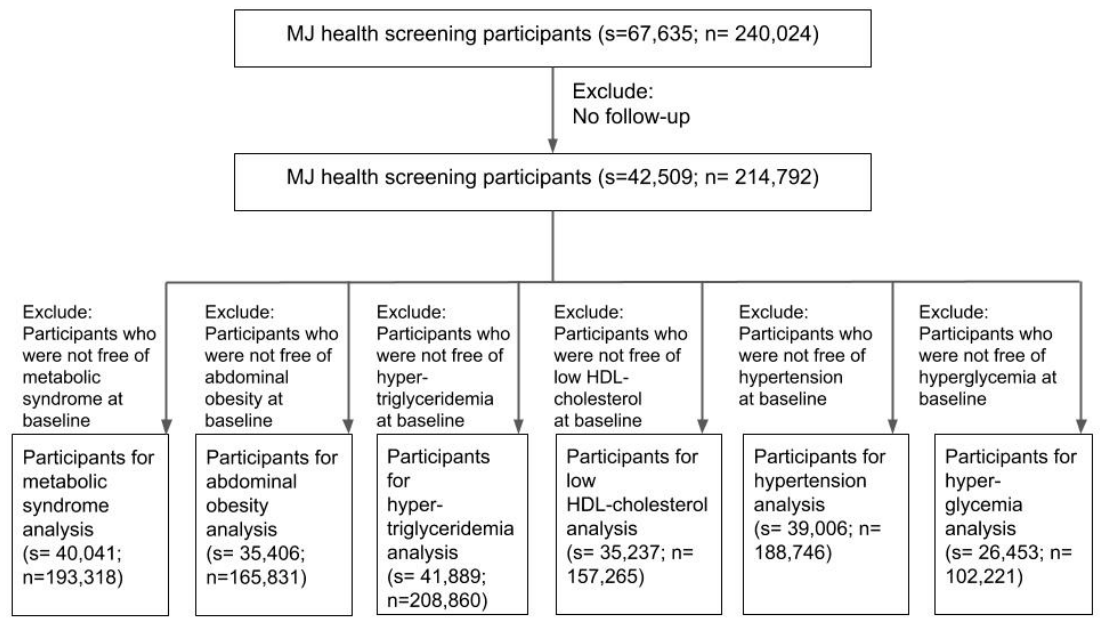
Figure 2. Participant flow diagram illustrating the exclusion criteria for analysis of metabolic syndrome and its components (s: participants, n: